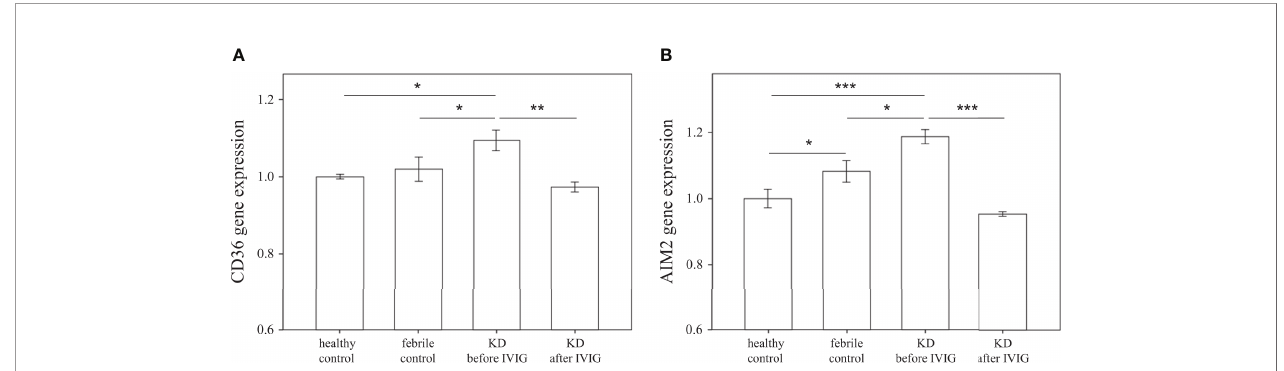
FIGURE 2 | Comparison of relative mRNA expression levels on HTA 2.0 microarray between patients with Kawasaki disease before IVIG (KD1, n=18), after IVIG (KD2, n=18), healthy controls (HC, n=18), and febrile controls (FC, n=18). (A) Comparison of relative CD36 mRNA expression levels (mean ± SEM, HC: 1 ± 0.01, FC: 1.02 ± 0.03, KD1: 1.09 ± 0.03, KD2: 0.97 ± 0.01) (B) Comparison of relative AIM mRNA expression levels (mean ± SEM, HC: 1 ± 0.03, FC: 1.08 ± 0.03, KD1: 1.19 ± 0.02, KD2: 0.95 ± 0.01). An asterisk denotes a p-value of less than 0.05.